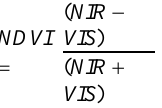
Figure 1. Map showing the study area The topography of Tamilnadu includes coastal plains in the eastern region and hills and uplands in the western region. More than half the area of state accounts to plain surface. The coastal districts in the east like Chennai, Cuddalore,